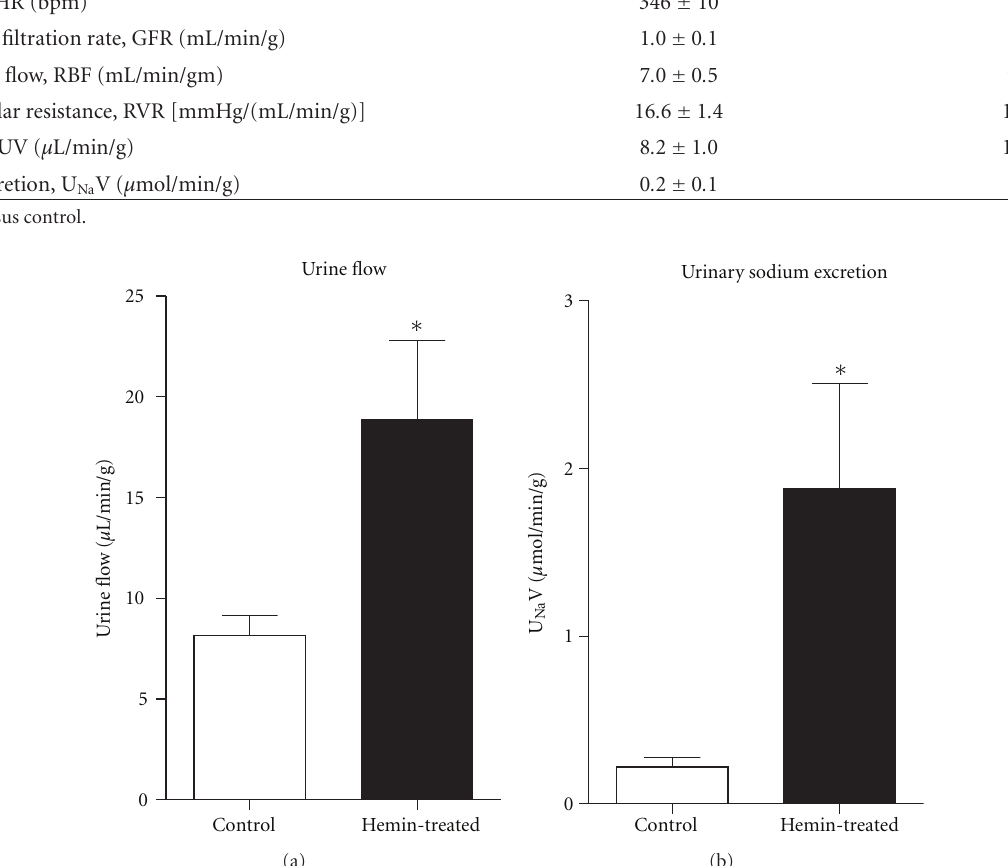
Figure 3: Urine flow (UV) and urinary sodium excretion (U Na V) in hemin-treated rats ( n = 6) compared to control rats ( n = 7). Results are expressed as mean ± SE for each group, ∗ P < 0 . 05 versus